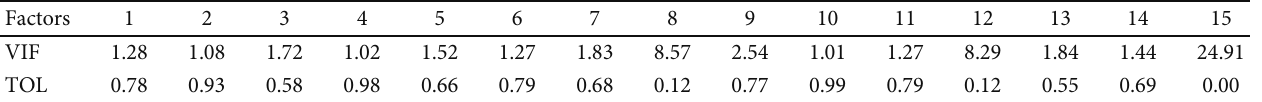
Table 4: Analysis result table based on multicollinearity diagnosis